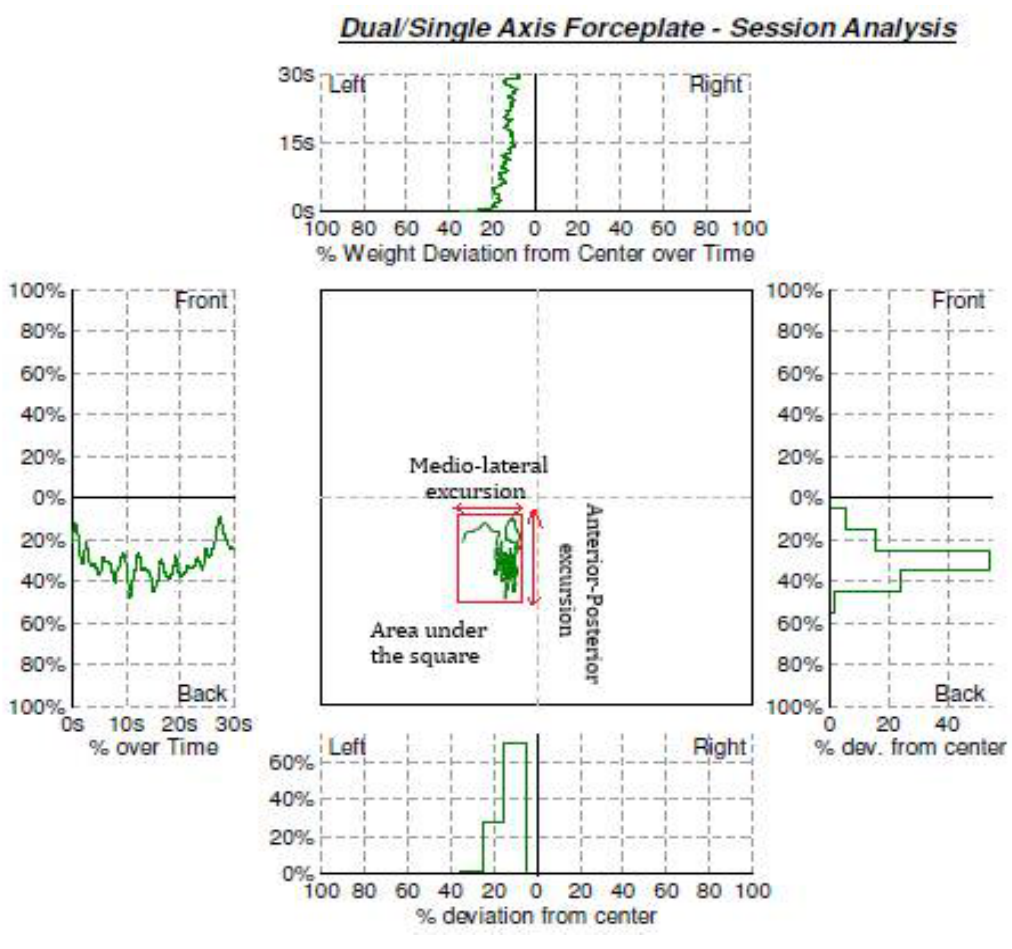
Figure 2. Force plate session analysis graph and parameter description.